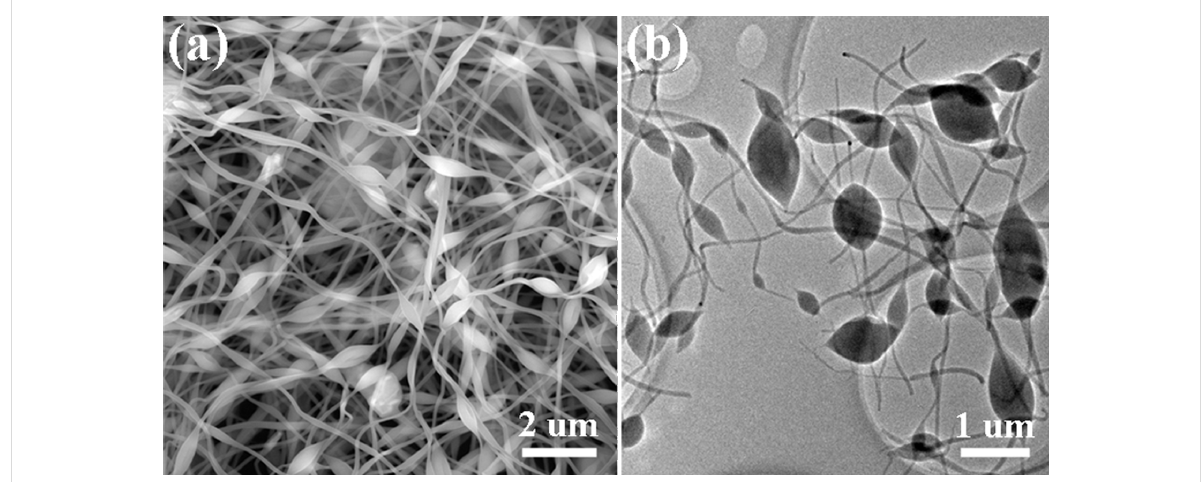
Figure 1: (a) SEM and (b) TEM images of the network of spindle-like carbon nanofibers anchored with MnO and